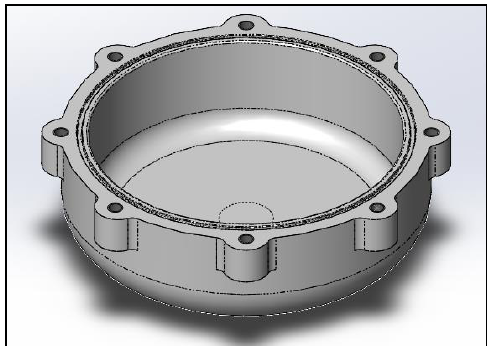
Figure 4. WCH box final design.